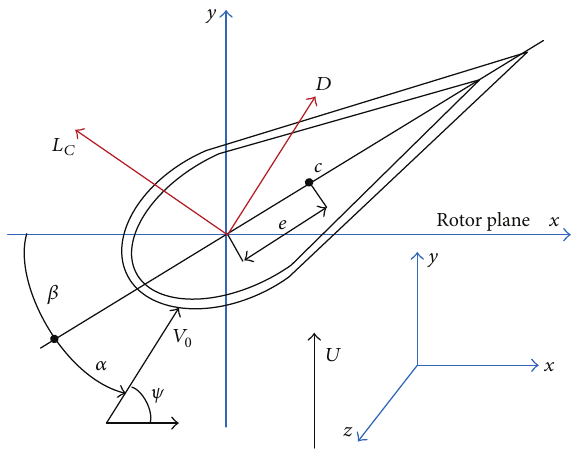
Figure 1: Coordinate system and aerodynamic forces of cross